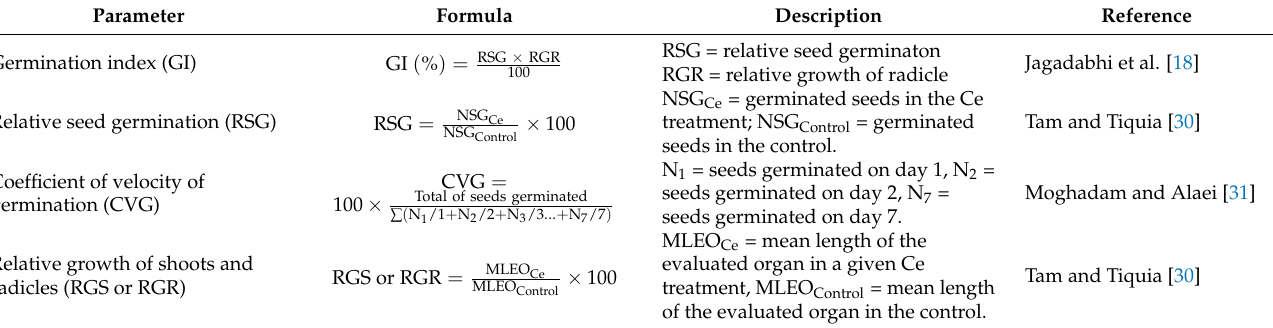
Table 1. Germination parameters and relative growth of shoots and radicles, formulas, description of variables and references considered to evaluate the effect of cerium (Ce) on tomato ( Solanum lycopersicum L.) under controlled conditions.